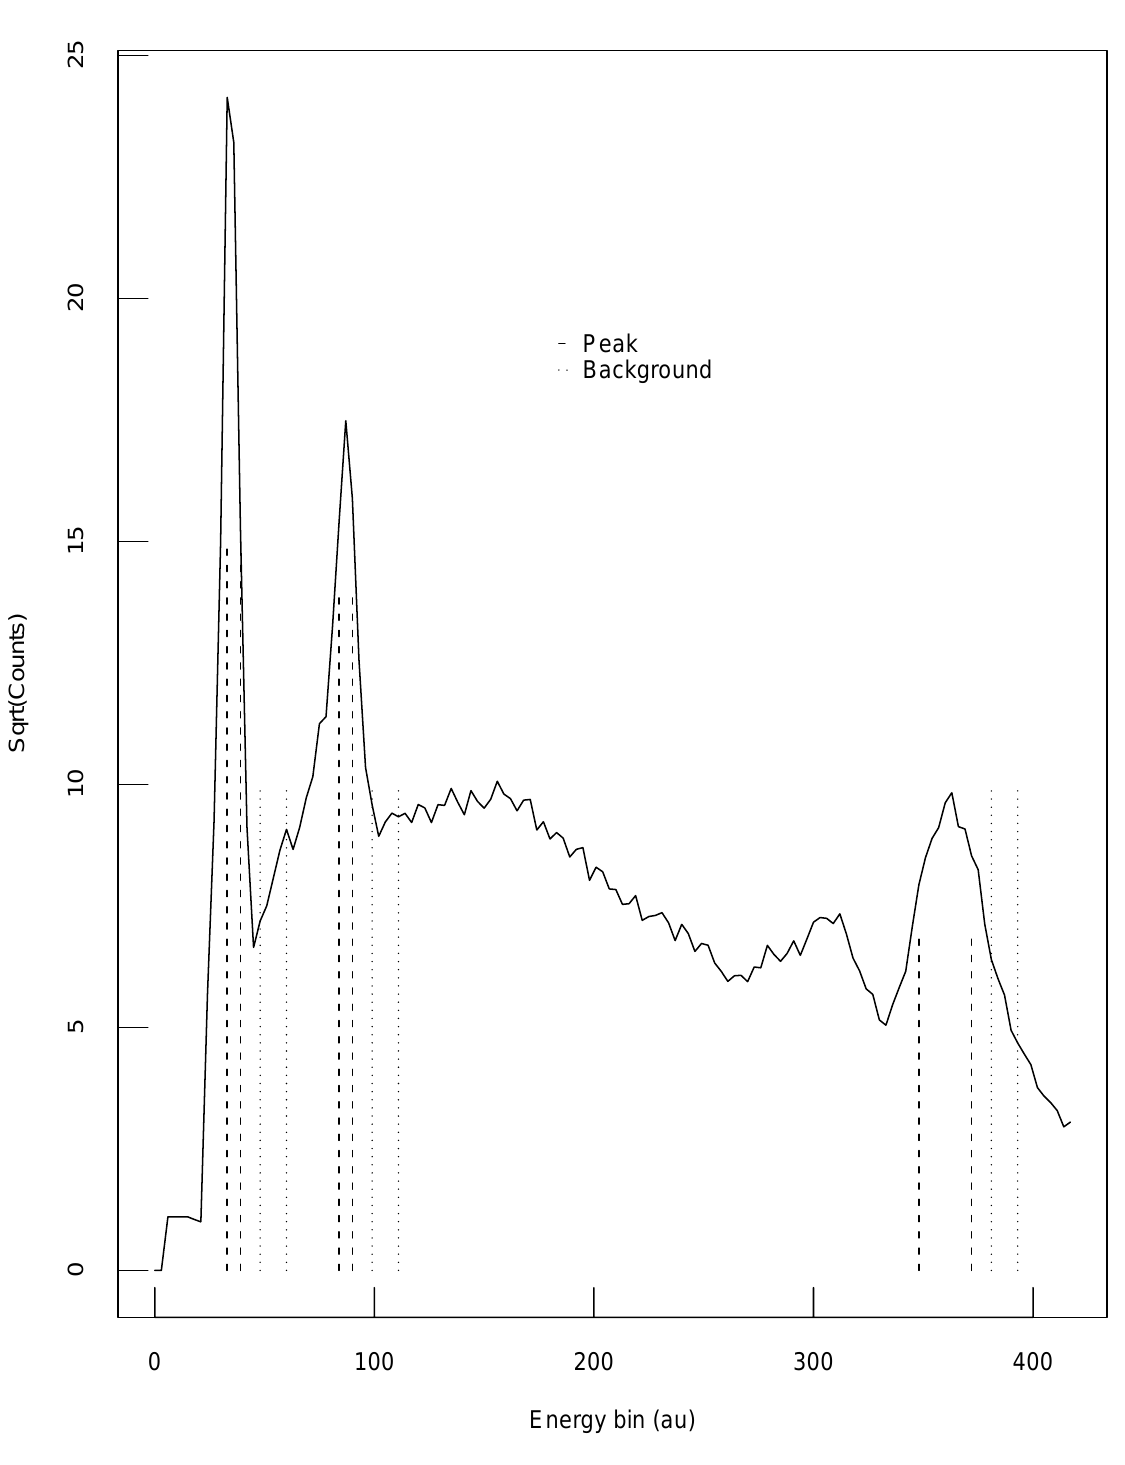
Figure 2. Example region of interest and corresponding background that can lead to the PPP